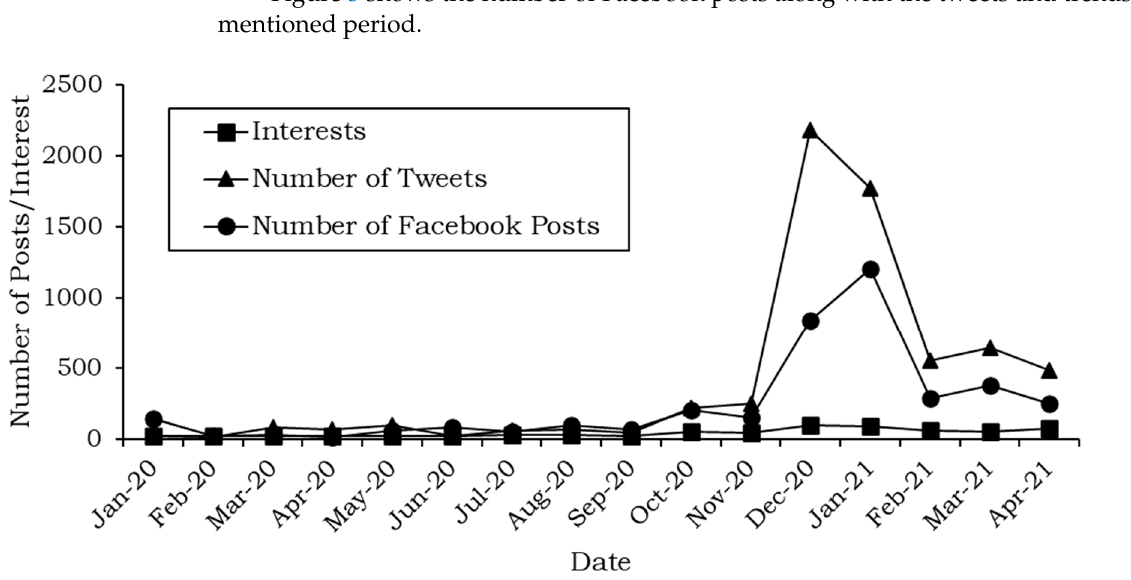
Figure 3. Number of Facebook posts in the collected data.